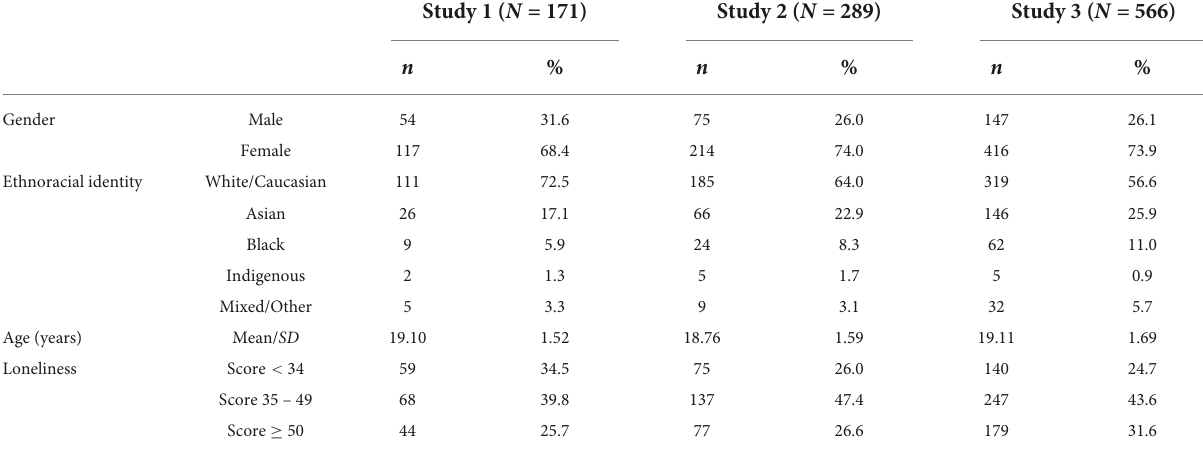
TABLE 1 Demographic description and prevalence of loneliness for participants of all three